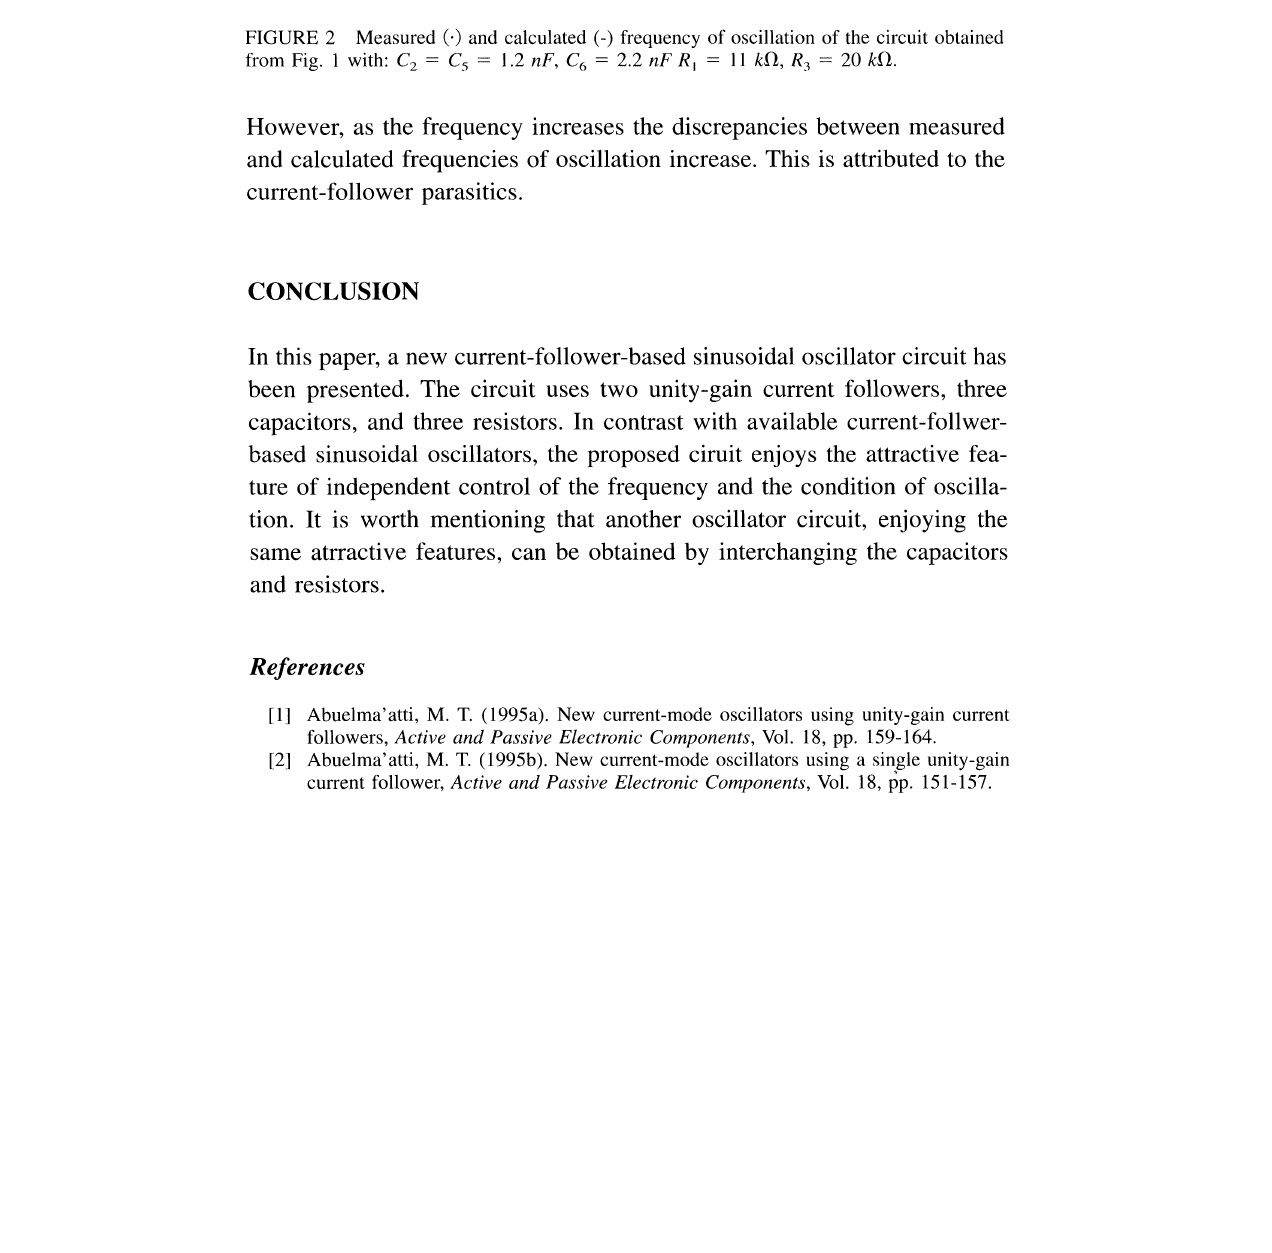
FIGURE 2 Measured (.) and calculated (-) frequency of oscillation of the circuit obtained from Fig. with: C2 C.s 1.2 nF, C6 2.2 nF R 11 k, R. 20